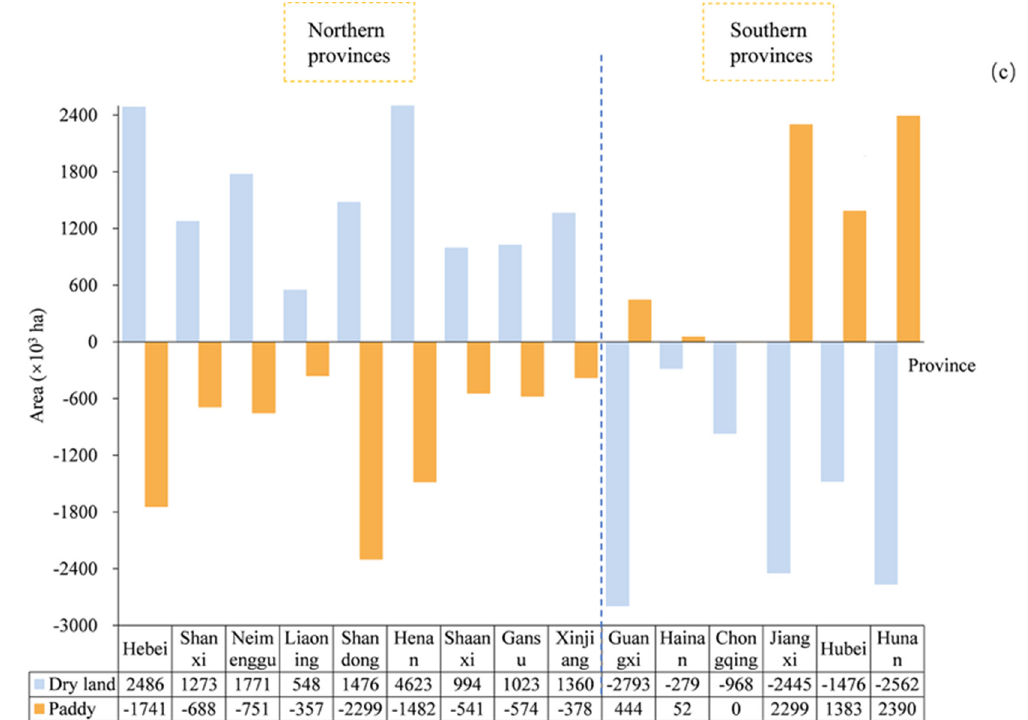
Figure 2. Cross-regional occupation and supply of cultivated land areas between Chinese provinces. ( a ) The first group, ( b ) the second group, ( c ) the third